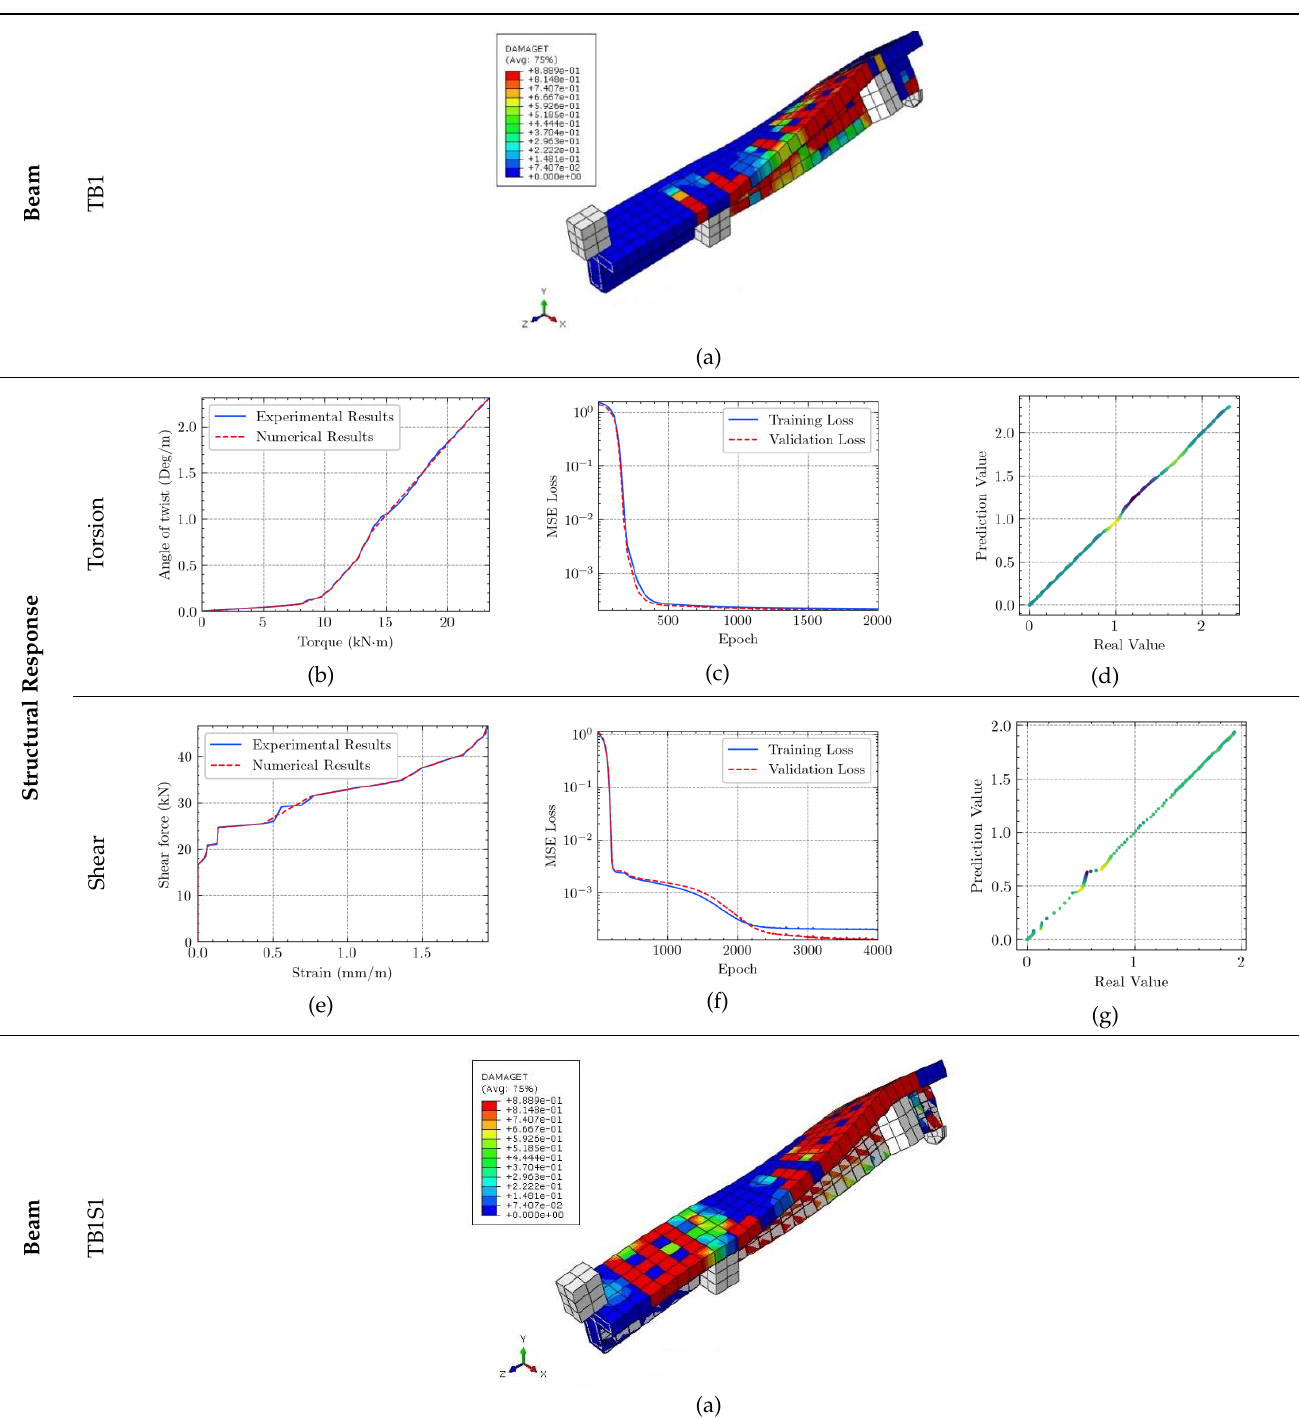
Table 7. Structural response and ANN results of T-Beams subjected to combined torsion and shear.